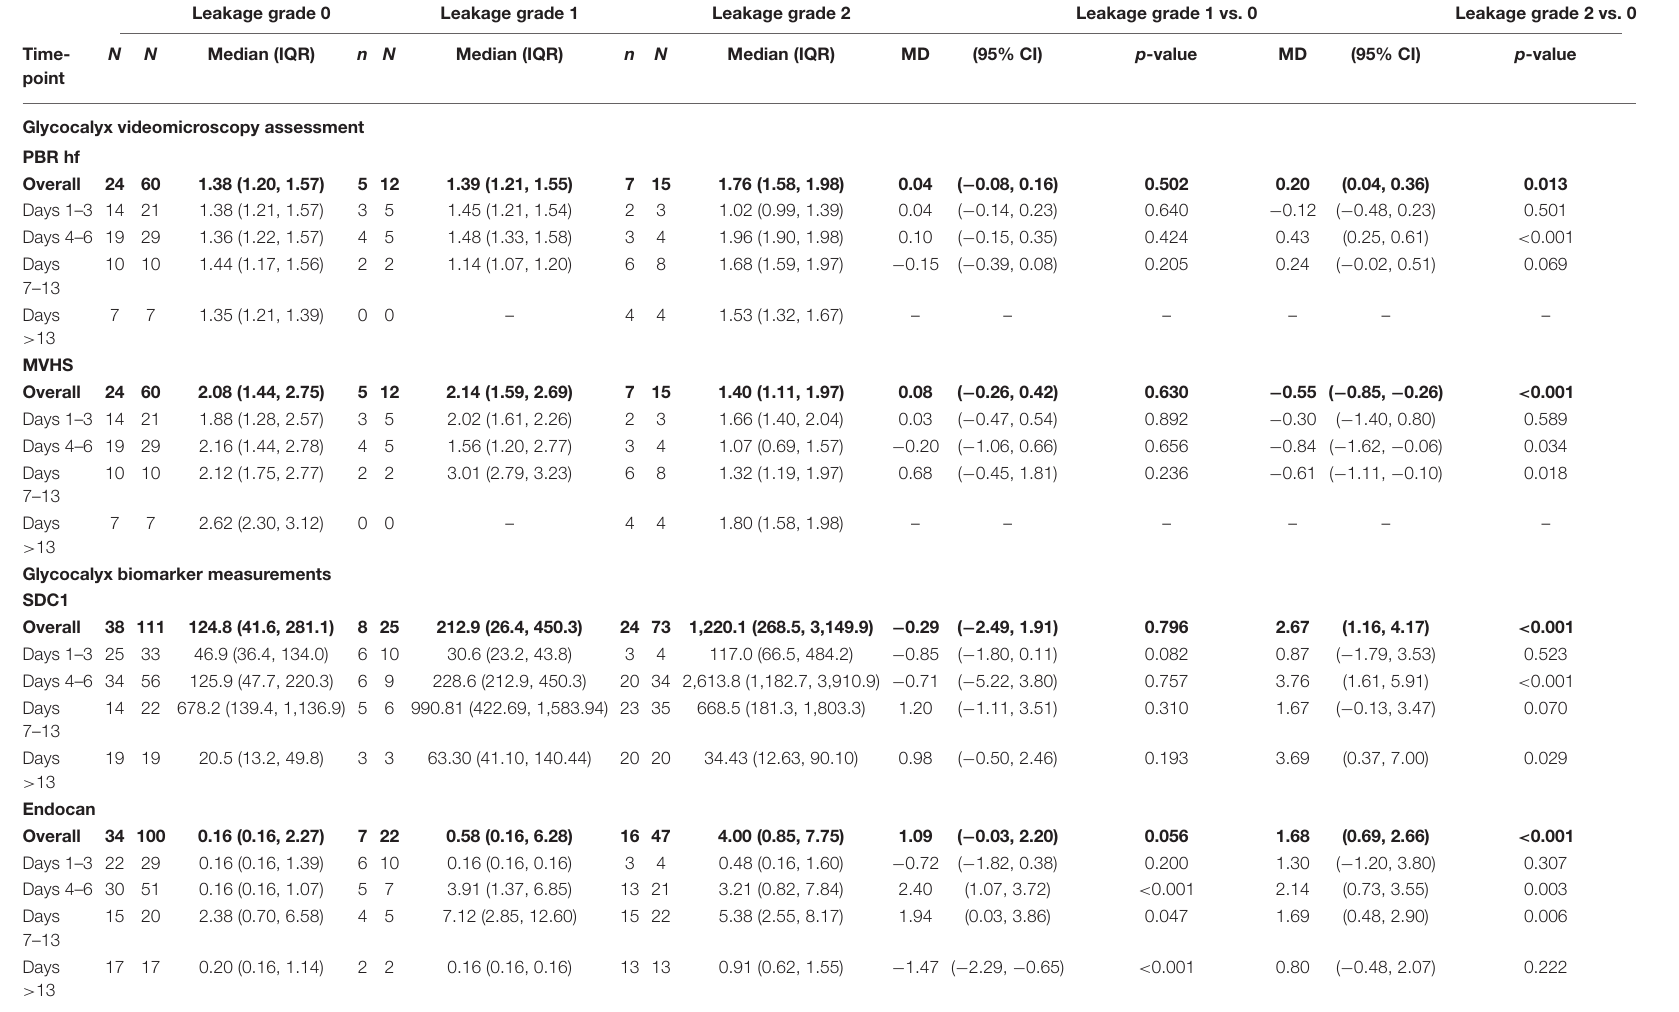
TABLE 3 | Glycocalyx parameters for outpatient and inpatients with laboratory confirmed dengue by plasma leakage grade and disease phase. Leakage grade 0 Leakage grade 1 Leakage grade